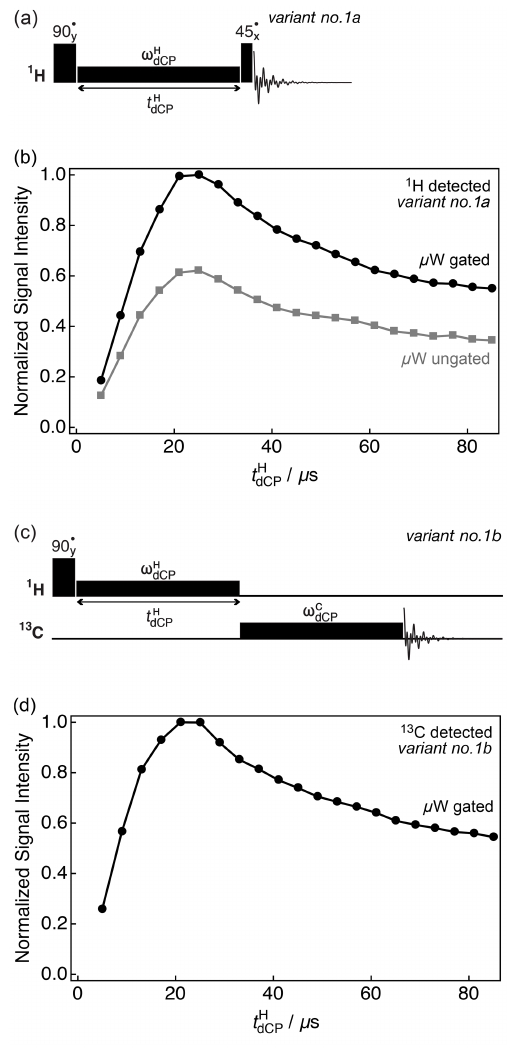
Figure 2. Simplified schematic representations of (a) variant no. 1a and (c) variant no. 1b of the d CP rf-pulse sequence. Experimental (b) 1 H and (d) 13 C NMR signal intensities of I as a function